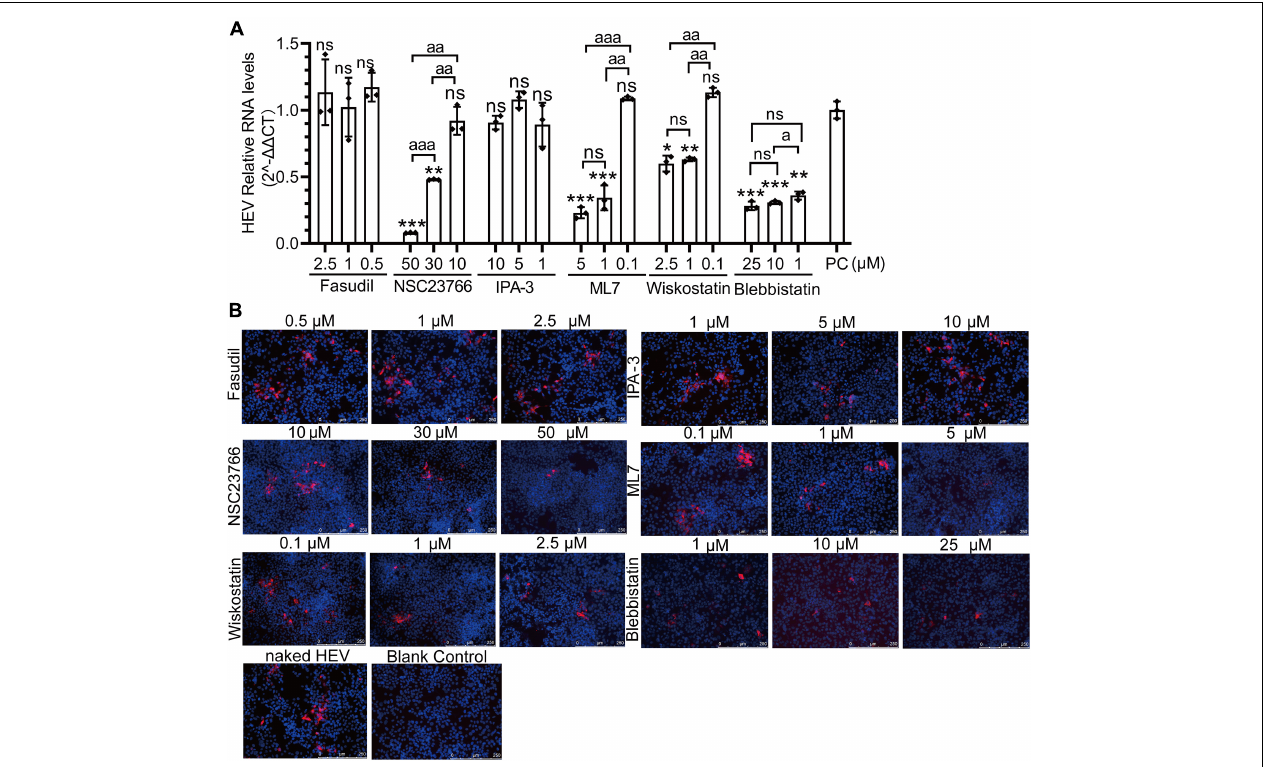
FIGURE 8 | CDC42/RAC1-MRCK-MYLK-NMIIA and CDC42/RAC1-(N-) WASP-Arp2/3 signaling pathways participate in non-enveloped HEV infection in HepG2/C3A cells. Relative mRNA levels (A) and capsid protein levels (B) of non-enveloped HEV-3 at 5 dpi in HepG2/C3A cells treated with Fasudil, NSC23766, IPA-3, ML7, wiskostatin, and blebbistatin. The results were normalized with GAPDH mRNA in each group. The capsid protein (red) location was analyzed, and the nucleus indicated DAPI (blue) staining in the images. Scale bars, 250 µ m. ns, no significant; * and a, P < 0.05; ** and aa, P < 0.01; *** and aaa, P <